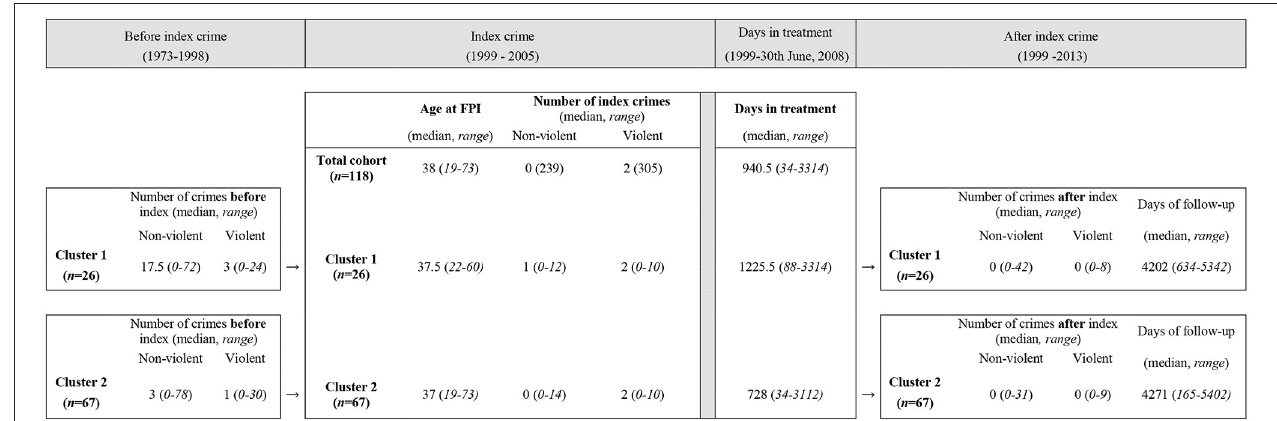
were considered separately, only one variable reached statistical significance, using a Bonferroni adjusted alpha level of 0.007; age at first crime, F (1, 90) = 109.82, p = 0.000, partial eta squared =